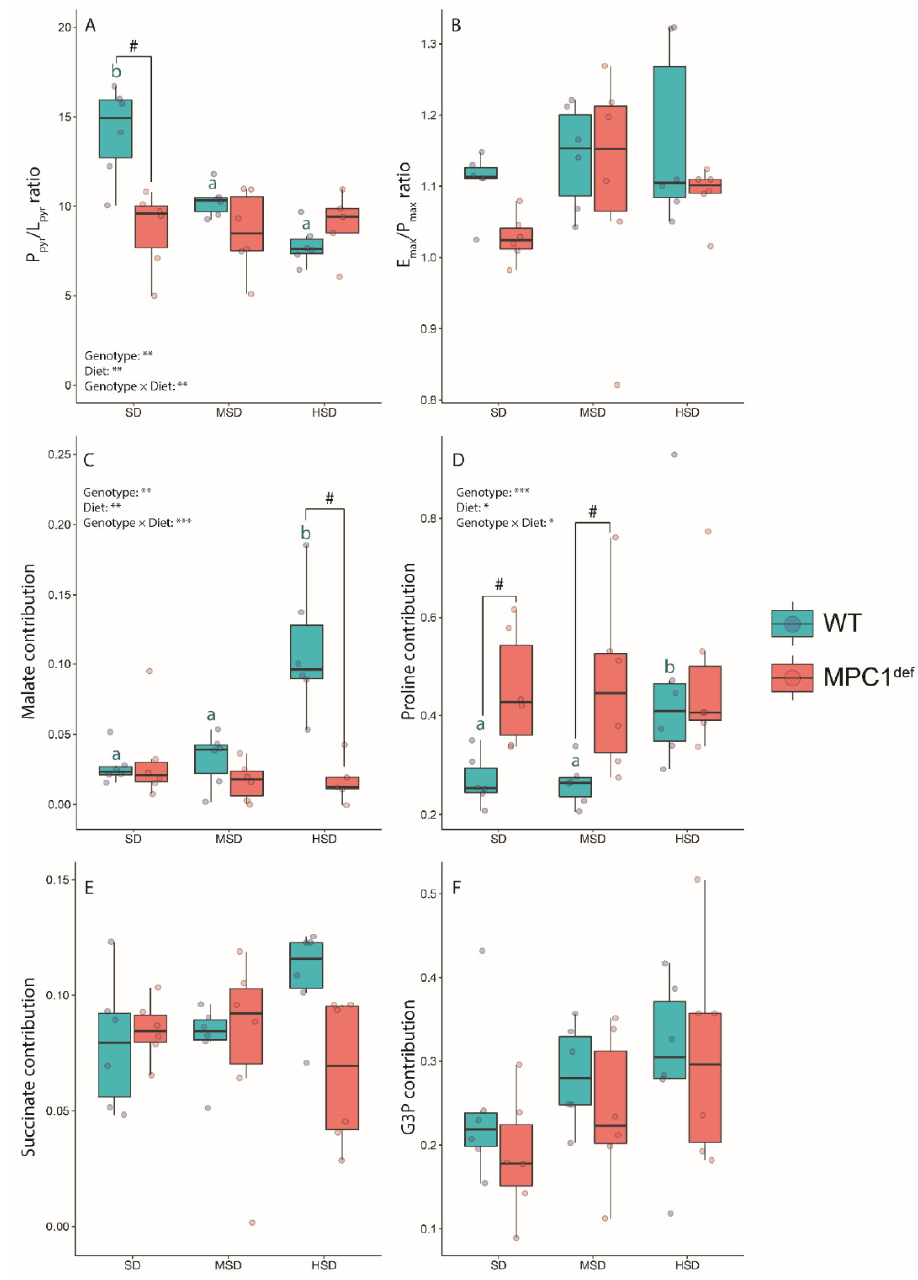
Figure 2. Calculated mitochondrial ratios and substrate contributions measured in permeabilized thorax of Drosophila melanogaster WT and MPC1 def exposed to the di ff erent experimental diets (SD, MSD, or HSD): ( A ) P pyr / L pyr ratio (CI pyr -OXPHOS / CI pyr -LEAK), ( B ) E max / P max ratio (CI + ProDH + CII + mG3PDH-ETS / CI + ProDH + CII + mG3PDH-OXPHOS), ( C ) malate contribution ((CI pyr + mal -OXPHOS − CI pyr -OXPHOS) / CI pyr -OXPHOS), ( D ) proline contribution ((CI + ProDH-OXPHOS − CIc-OXPHOS) / CIc-OXPHOS), ( E ) succinate contribution ((CI + ProDH + CII-OXPHOS − CI + ProDH-OXPHOS) / CI + ProDH-OXPHOS), and ( F ) G3P contribution ((CI + ProDH + CII + mG3PDH-OXPHOS − CI + ProDH + CII-OXPHOS) / CI + ProDH + CII-OXPHOS). The results correspond to the mean ± SEM for each condition (N = 6). Statistical analysis: stars represent statistical results from ANOVAs with * p < 0.05, ** p < 0.01, and *** p < 0.001; # represents significant di ff erences between genotypes for each experimental diet detected using the estimated marginal means method; and letters denote di ff erences between experimental diets for each genotype, with “a” and “b” representing di ff erences between the WT flies.